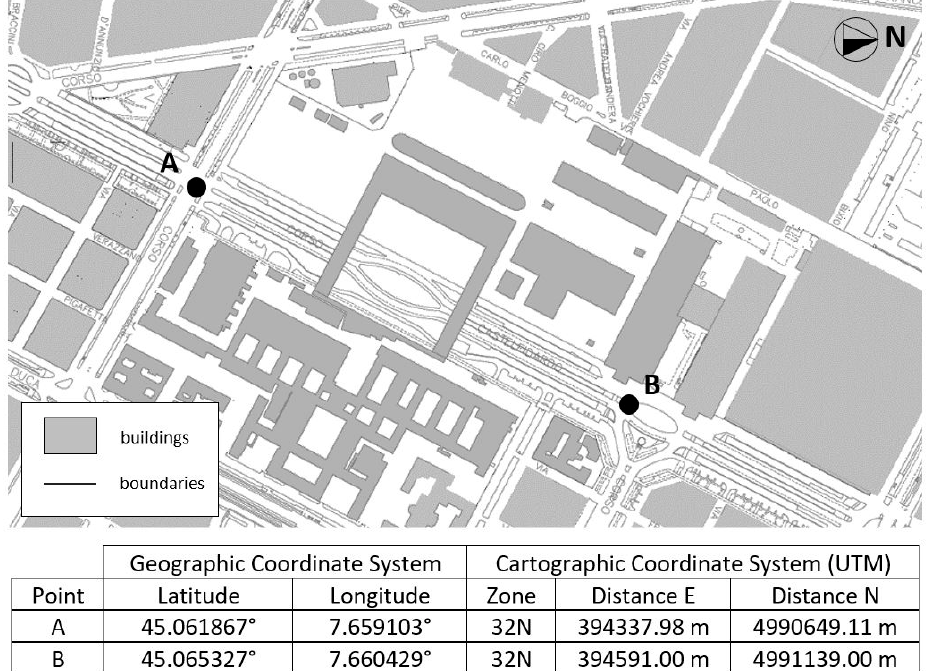
Figure 9. Maps with geographic and cartographic coordinates of the two extremes of the road section investigated as a case study.